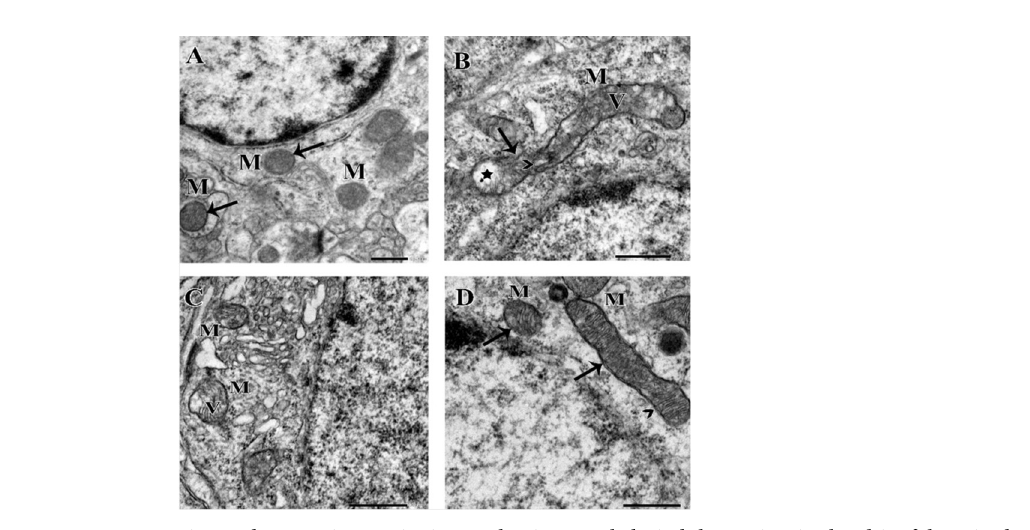
Fig 10. Electron microscopic pictures showing morphological changes in mitochondria of the striatal neurons of rats treated with different doses of yucca alone or with rotenone. (A) The control group shows normal mitochondria (M) with their double membranes (arrows), regular cristae and healthy matrix. (B) A micrograph of the rotenone group showing a disintegrated mitochondrion (M), with discontinuity of its membranes (arrow). The cristae are distorted (arrowhead) and the matrix shows hypointensity ( � ) and vacuolization (V). (C) A micrograph of the rotenone + low dose of yucca group shows mild improvement. The mitochondrial membranes are less disrupted, but the matrix still shows vacuoles (V). (D) A micrograph of the rotenone + high dose of yucca group showing a marked improvement of the mitochondria (M), with continuous membranes (arrows), regular lamellar cristae (arrowhead), and apparently normal